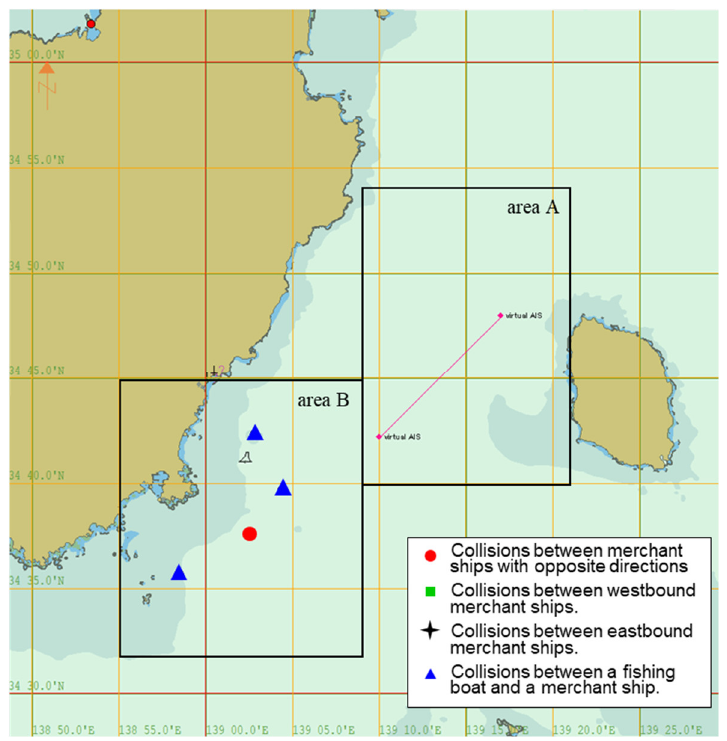
Figure 16. Collision locations in the period after the implementation of the RR (January 2018–March 2022). (Source: Japan-Marine Accident Risk and Safety Information System (J-MARIS) [34]). Table 2. Collision occurrences by encounter type.